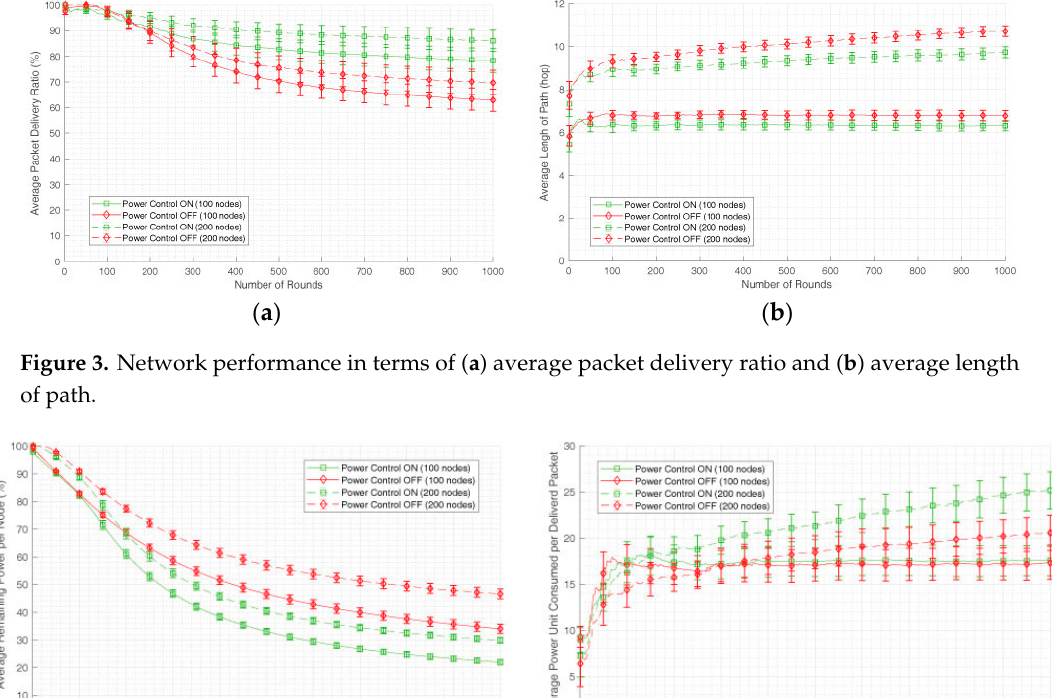
Figure 2. Network performance in terms of ( a ) number of inactive nodes and ( b ) number of disconnected nodes.